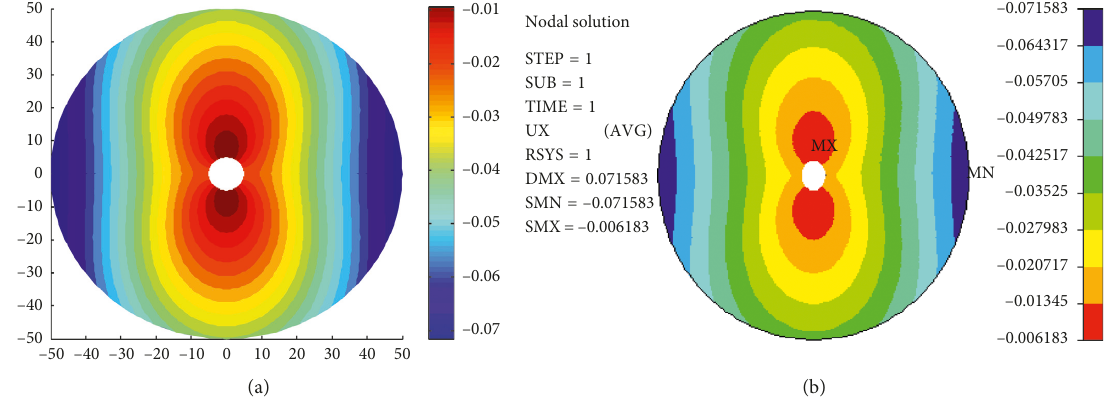
Figure 3: Cloud diagram of the radial displacement u